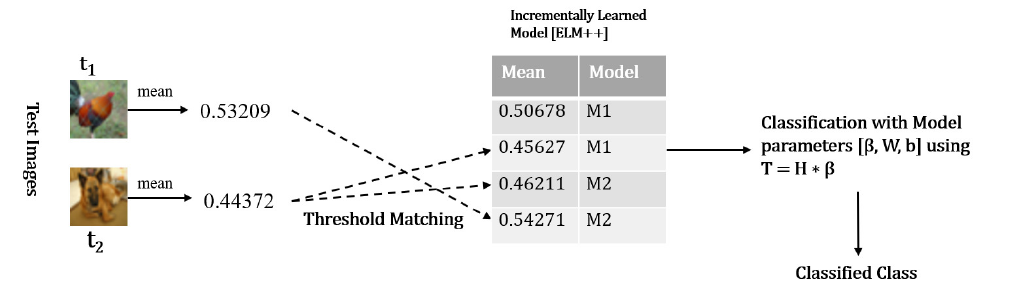
Figure 9. ELM++ to classify test